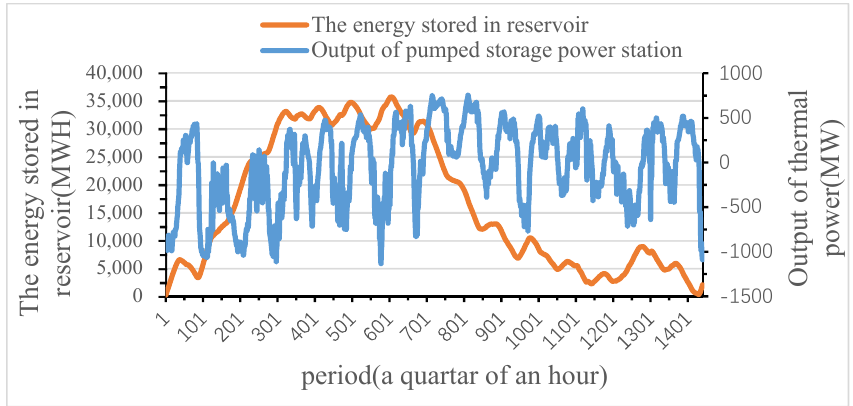
Figure 5. Operation of pumped-storage power station in heating off-peak period.